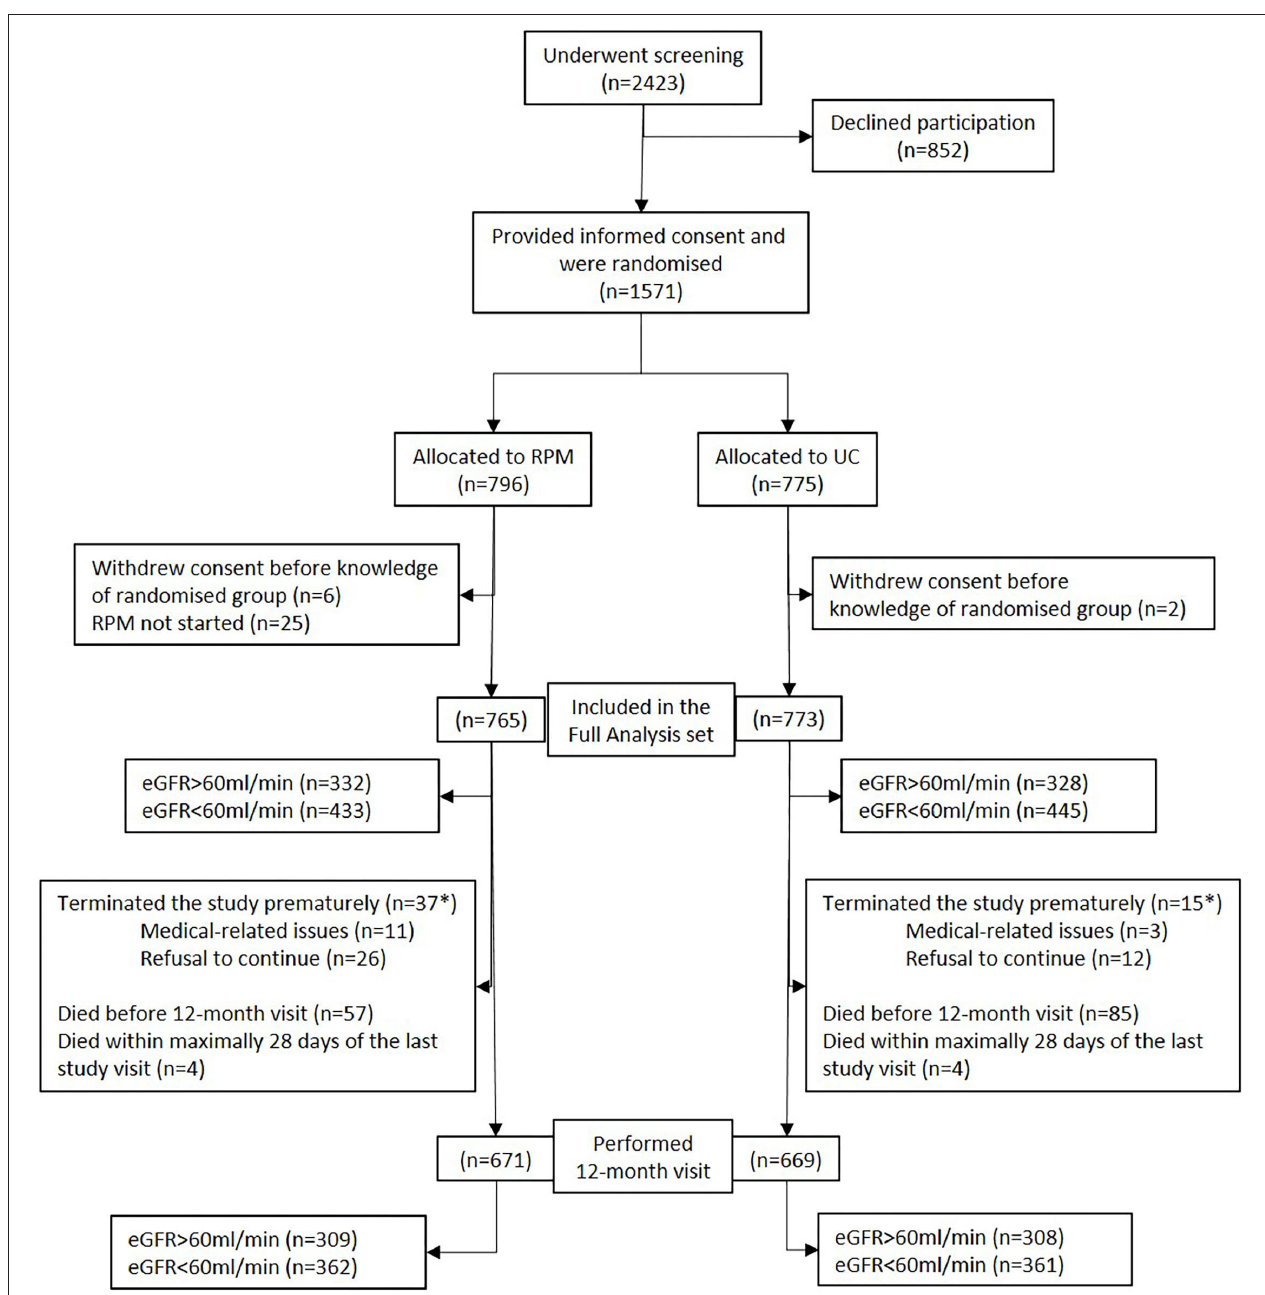
FIGURE 1 | Flowchart of the cohort. eGFR, estimated glomerular filtration rate; RPM, remote patient management; UC, usual care. *Survival status known up to 393 days post randomization for all patients who withdrew prematurely.